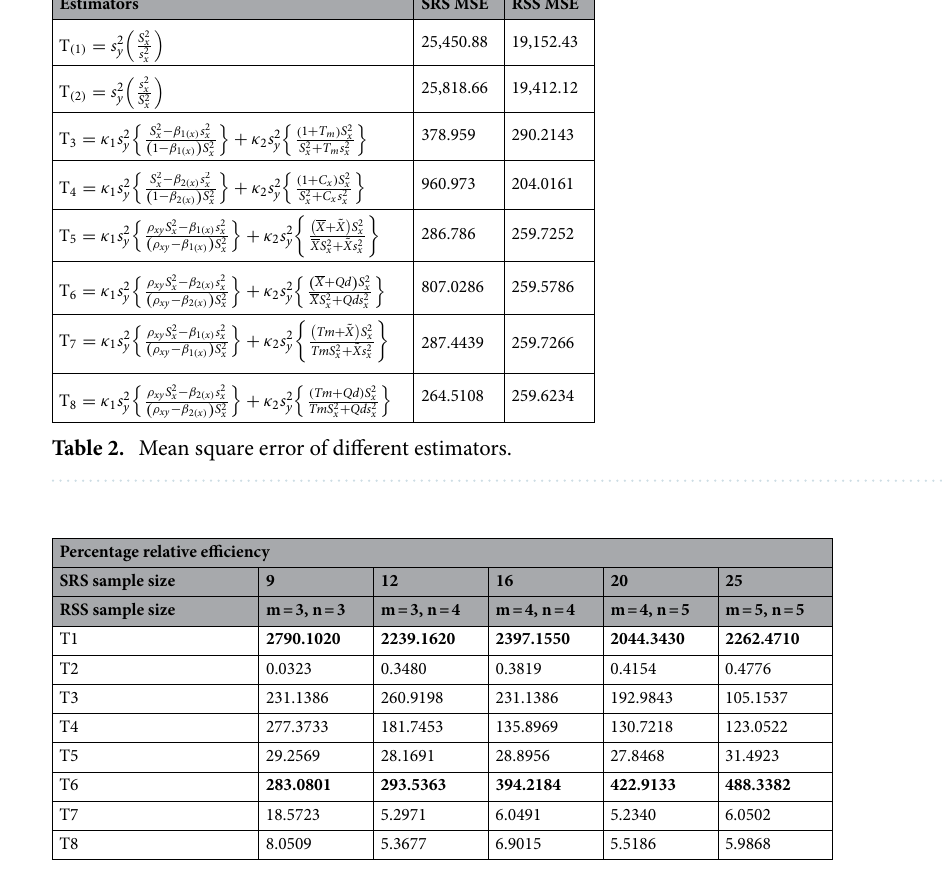
Table 3. Percent relative efficiencies (PREs) of estimators at rho = 0.90. Significant values are in bold.